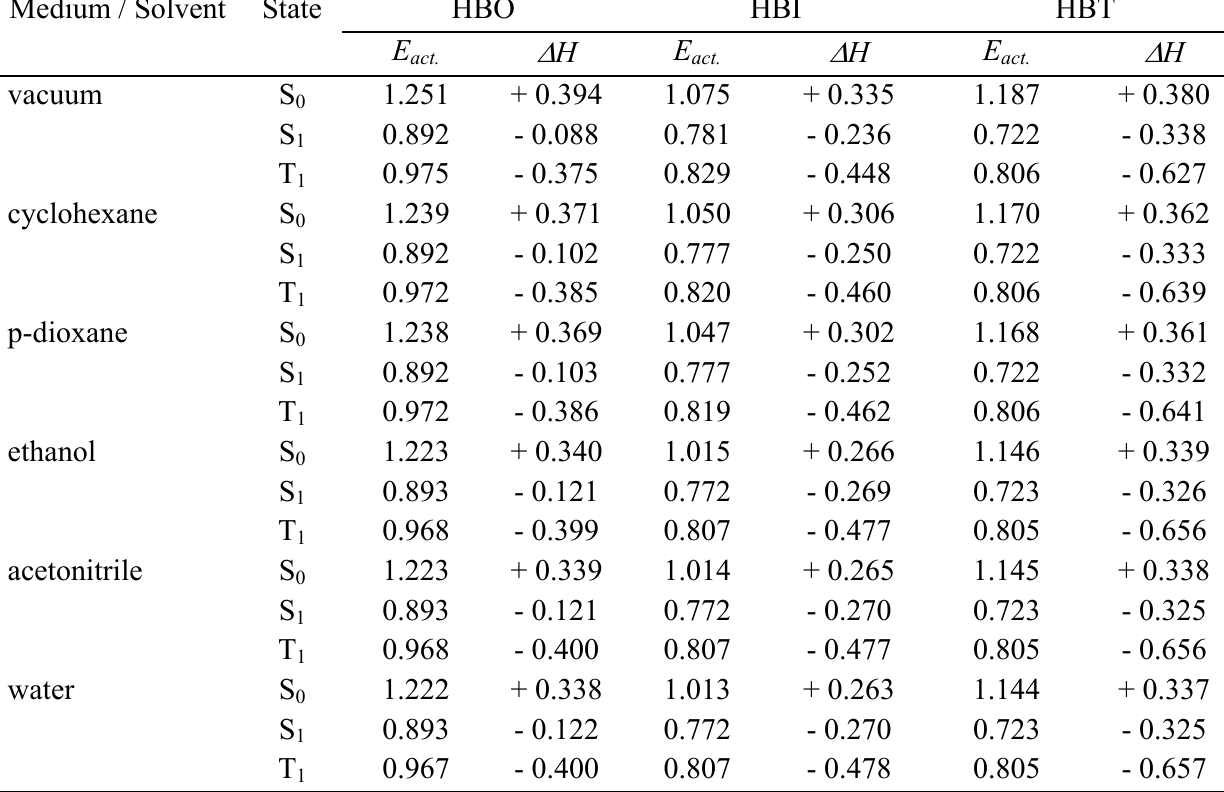
in eV) and reaction enthalpies ( ∆ H in eV) for the act , S and T states. 0 1 1